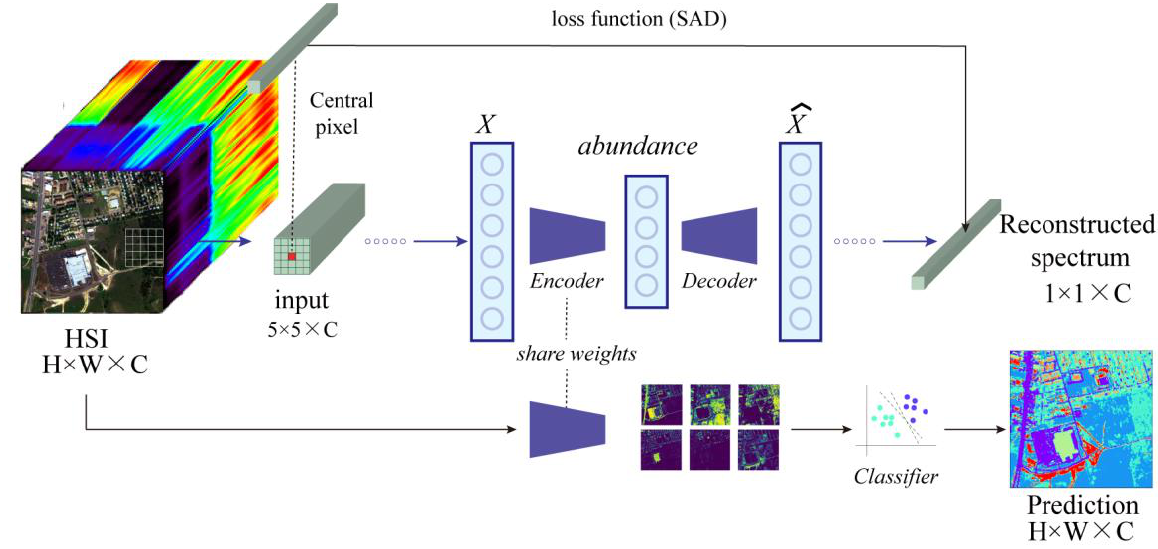
Figure 9. An overview of the proposed 3D autoencoder-based semi-supervised classification frame- work.